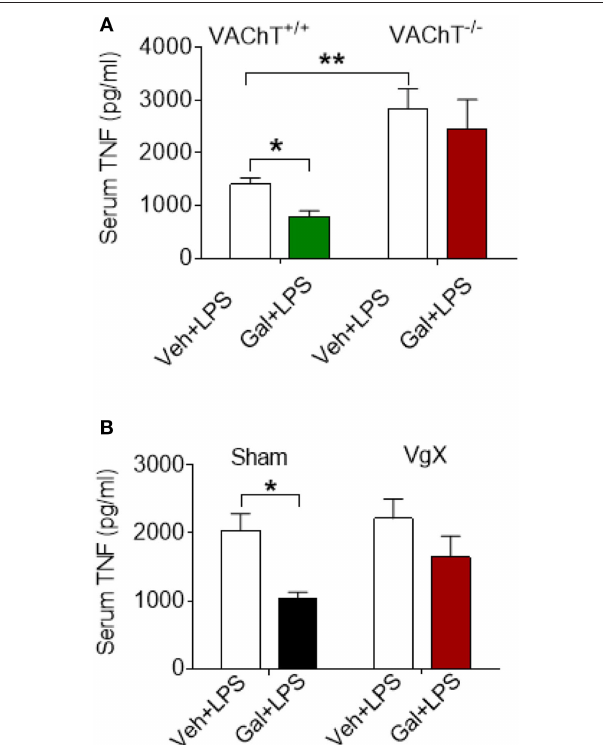
FIGURE 2 | Selective forebrain cholinergic deficit and vagotomy alter cholinergic suppression of peripheral pro-inflammatory cytokine levels. (A) Galantamine (Gal, i.p.) as compared to vehicle (Veh), suppresses serum TNF in VAChT + / + control mice, but not in VAChT − / − mice during endotoxemia, and serum TNF in vehicle injected VAChT − / − mice are higher as compared to VAChT + / + control mice (* P = 0.017, ** P = 0.007, two-way ANOVA, Sidak’s multiple comparisons test), n = 6–7 per group. (B) Vagotomy (VgX) abolishes the suppression of serum TNF in endotoxemic mice (* P = 0.019, two-way